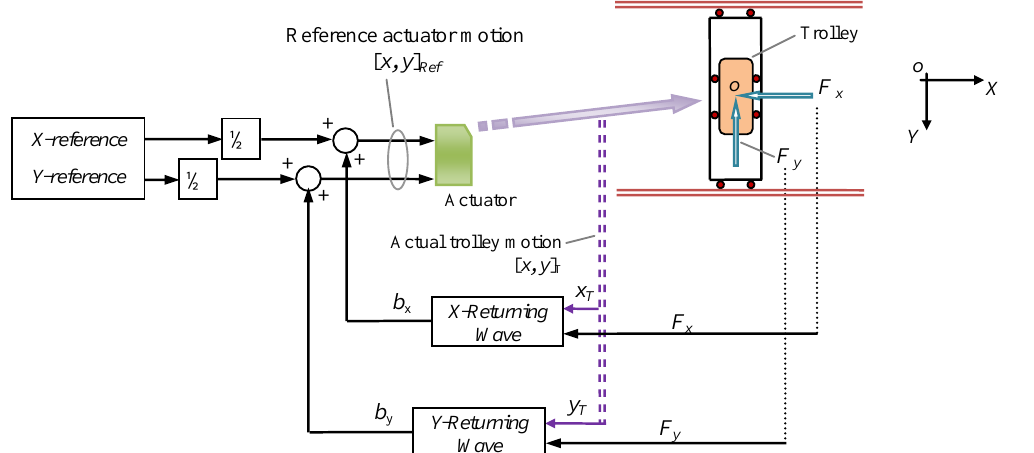
Fig.2: Representation of successive rotations to reach the body coordinates of the hanging load